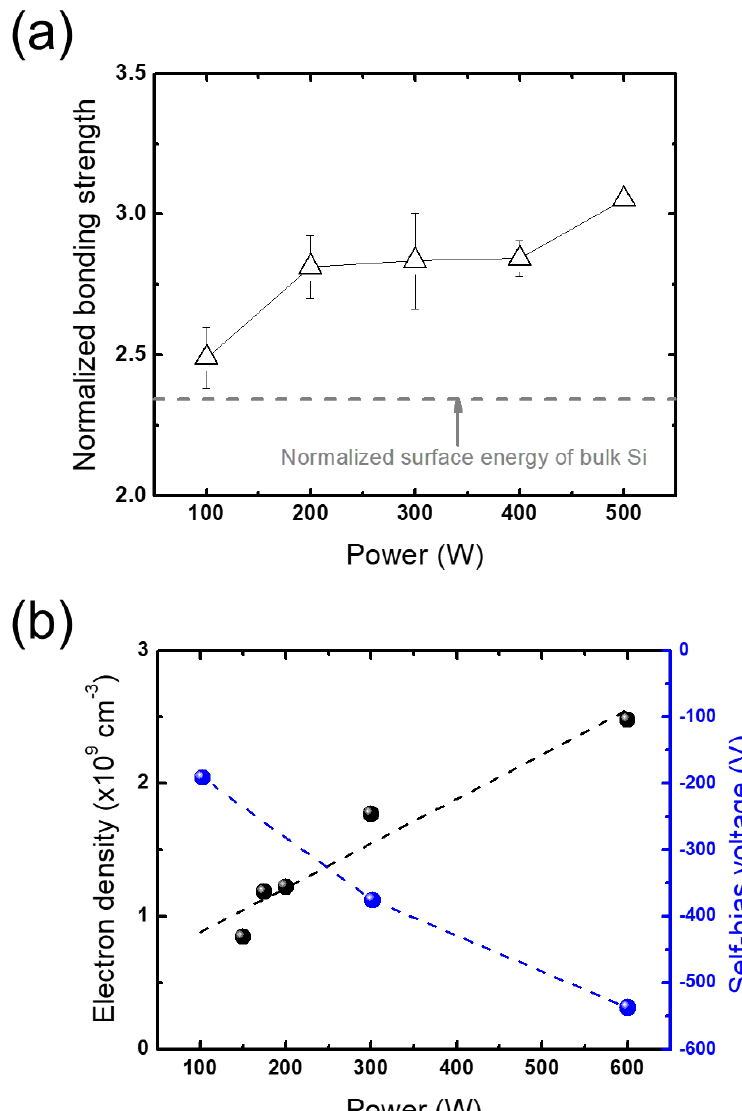
Figure 7. ( a ) Bonding strengths obtained from plasma treatment at different RF powers normalized to the bonding strength with no plasma treatment and ( b ) electron density and self-bias voltage measured at different RF powers.